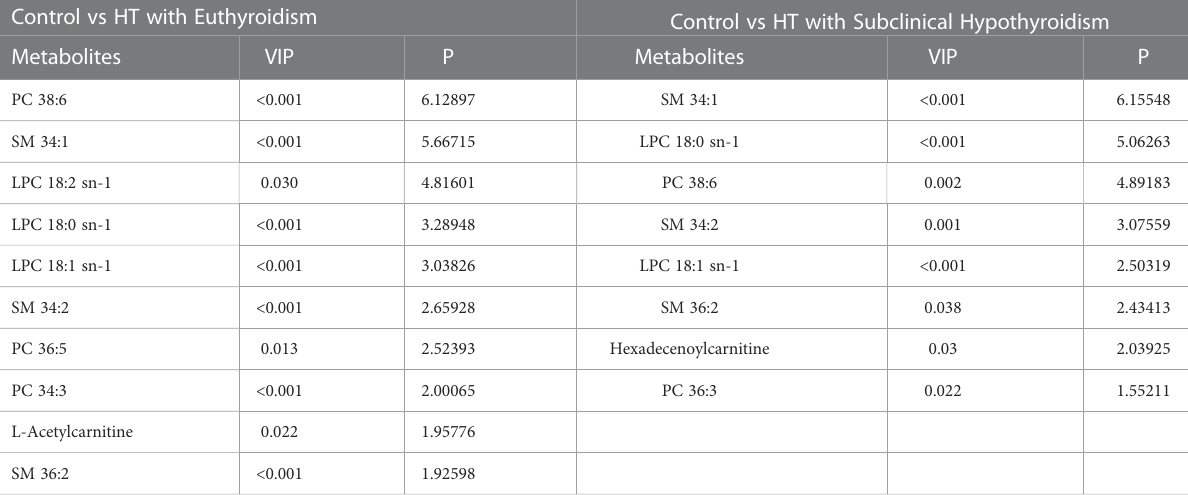
TABLE 4.1 The identi fi cation metabolites of control vs HTE and control vs HTS group. Control vs HT with Euthyroidism Control vs HT with Subclinical Hypothyroidism